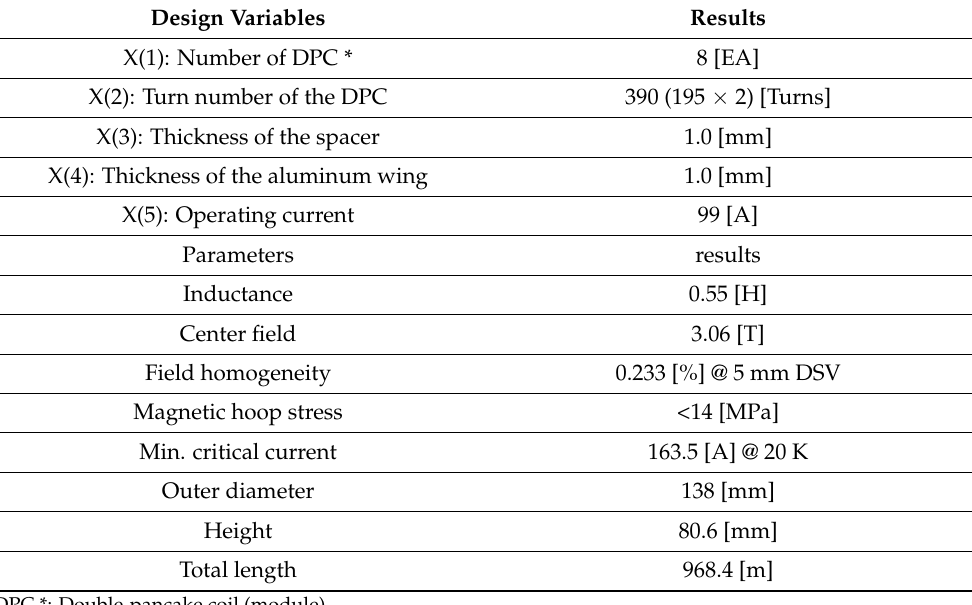
Table 2. Specifications of the Designed 3 T REBCO EMPS Magnet @ 20 K.